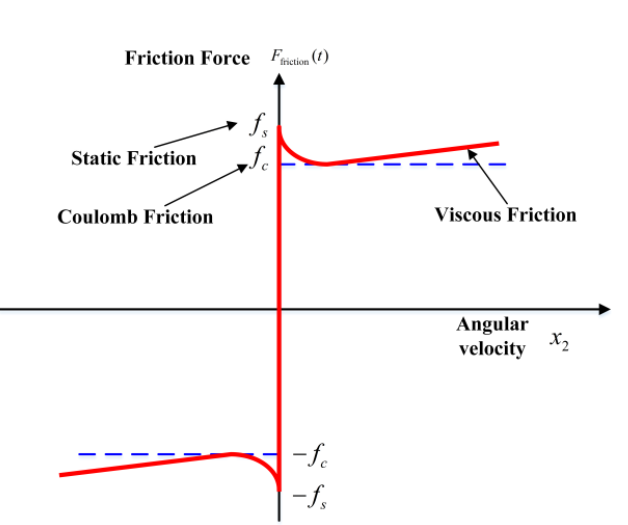
Figure 1. Stribeck friction curve.